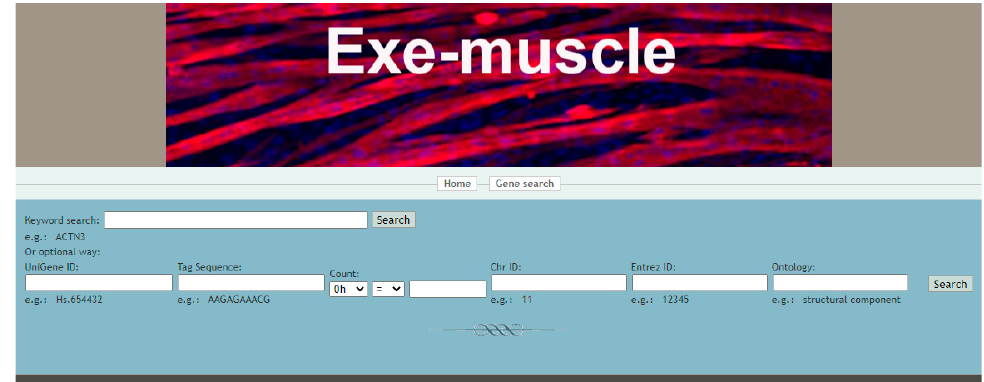
Figure 3. Gene search page of Exe-muscle. This page includes blanks for entering information